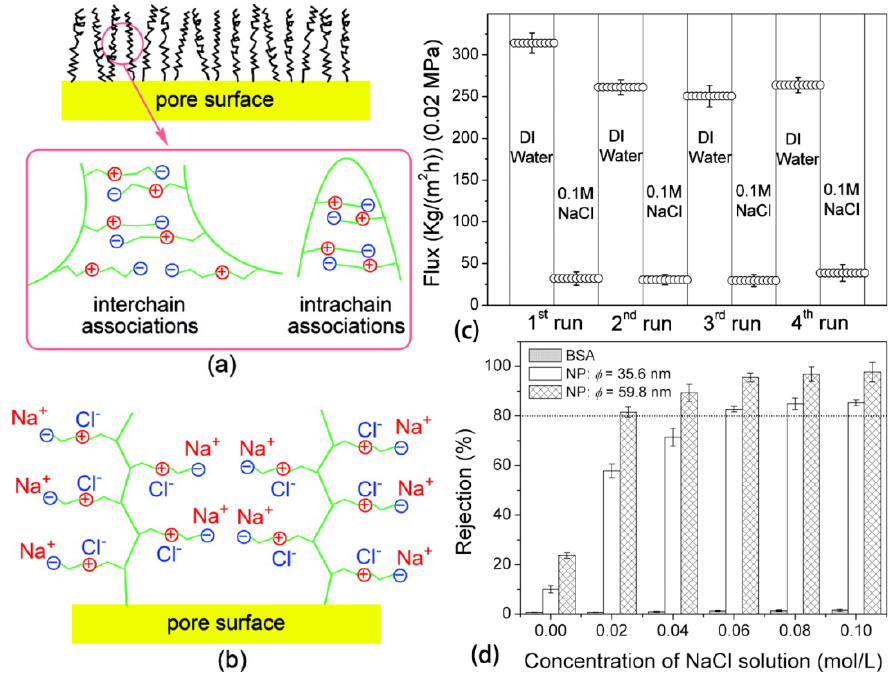
Figure 25. Various characteristic conformational states of PSBMA polymer chains in ( a ) DI water; and ( b ) NaCl solution; ( c ) Reversible electrolyte-responsive behavior of RC-g-PSBMA; ( d ) Dependence of rejection rates of BSA and NPs upon the concentration of NaCl solutions. Reprinted with permission from [161]. Copyright 2009 American Chemical